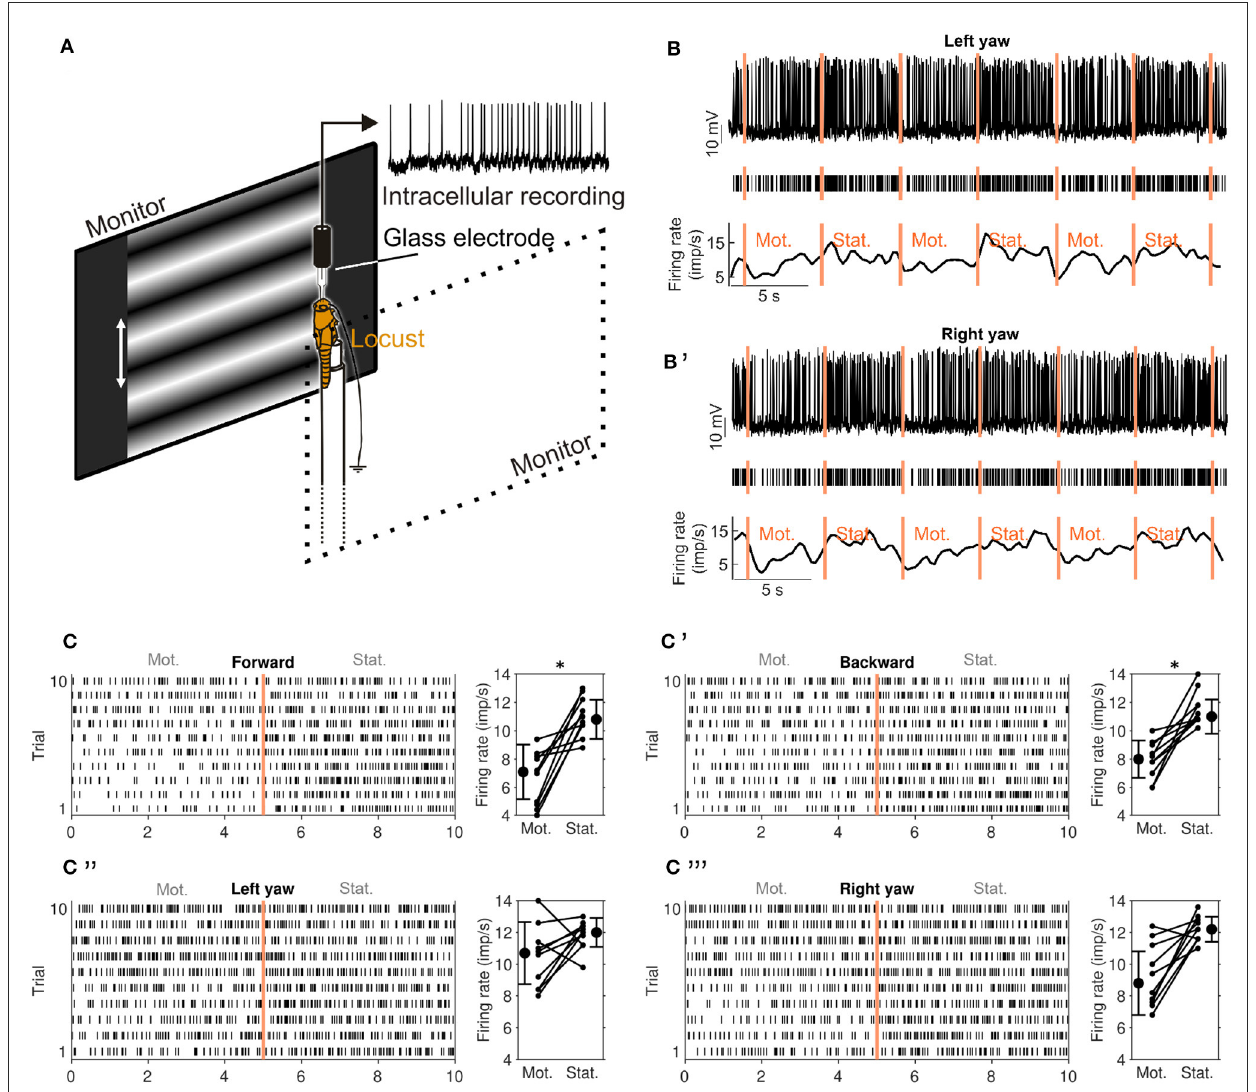
FIGURE2 Experimental setup and visual-motion response of a CL1a neuron (neuron 550 L in Supplementary Figures S1, S2). (A) Animals were mounted vertically and stimulated with motion of sinusoidal grating patterns on two laterally placed monitors. (B) Response of a CL1a neuron to wide-field visual motion that simulated horizontal left turning (left yaw). Raw data (top), detected spikes (middle) and smoothed firing rate estimate (bottom). Vertical lines indicate onset of stimulation phases: Motion (Mot.) and stationary phase (Stat.) were alternated, each pair constituting one stimulation trial. (B’) Same as B but for simulation of horizontal right turn motion (right yaw). (C) Raster plot (left) of all forward motion trials. Vertical line at 5 s indicates onset of stationary phase. Diagram on the right shows differences in firing rate between the motion (Mot) and stationary phase (Stat.) for each trial and mean firing rates for all trials. Error bars denote standard deviation. (C’–C”’) Same as C but for (C’) backward motion, (C”) left yaw and (C”’) right yaw rotation. An asterisk indicates ‘strong evidence’ in favor of the hypothesis that the firing rates differ between the motion and stationary phases (i.e., it indicates a Bayes factor ≥ 10 according to the conventions established by Kass and Raftery,